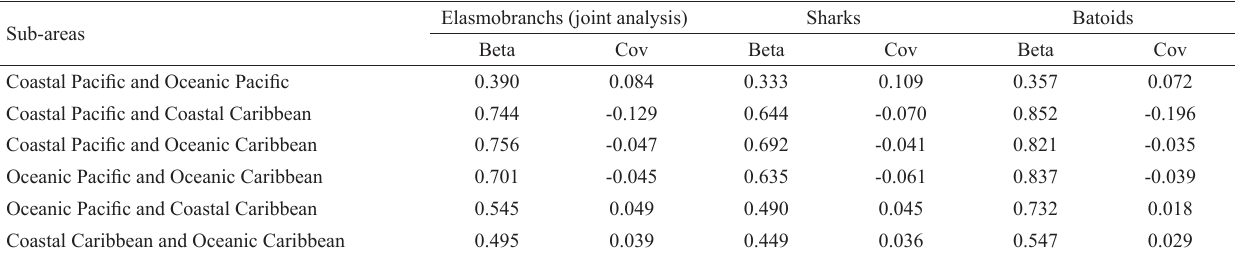
Table 2. Beta diversity values (β) and occurrence specific covariance (Cov) of shark and batoid species among the four tropical marine sub-areas of the Colombian Caribbean and